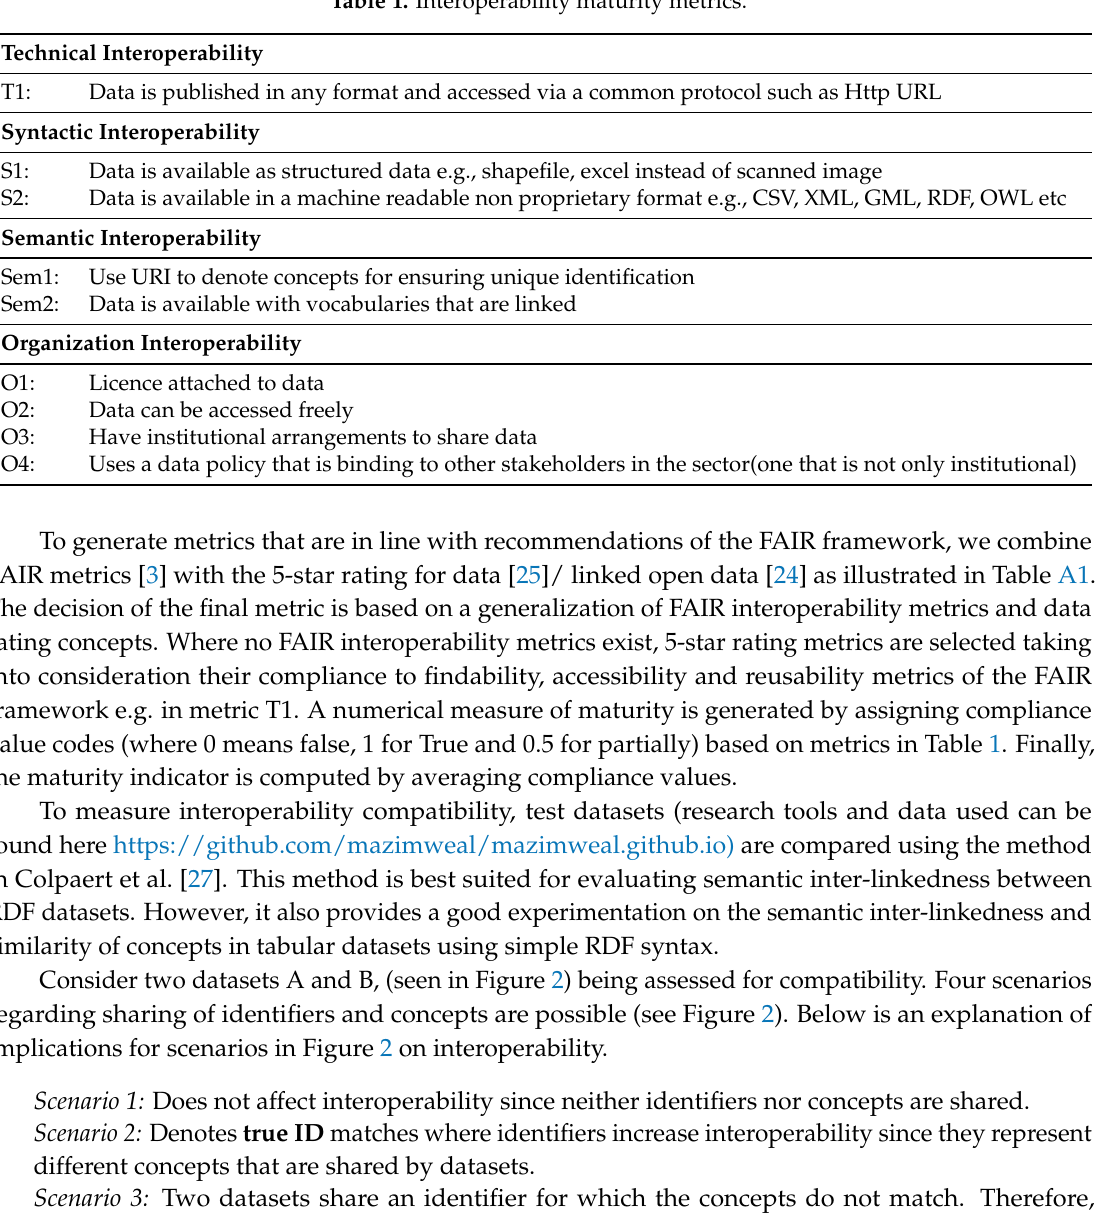
Table 1. Interoperability maturity